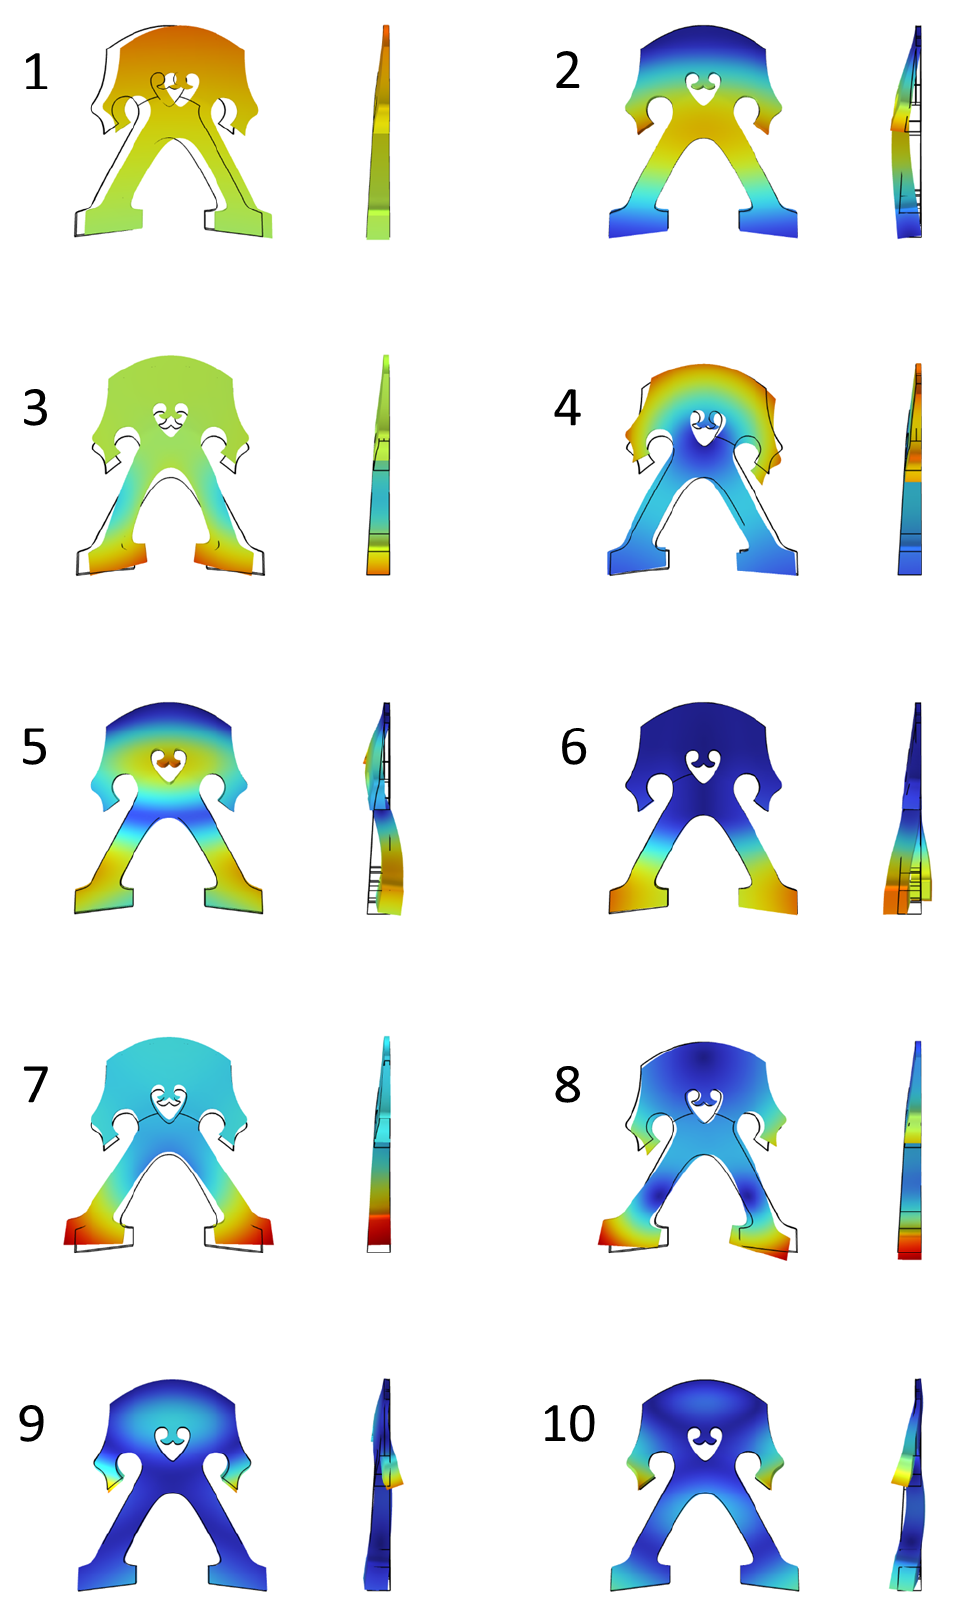
Figure A9. Mode shapes in spring boundary conditions (case (d)) for Model